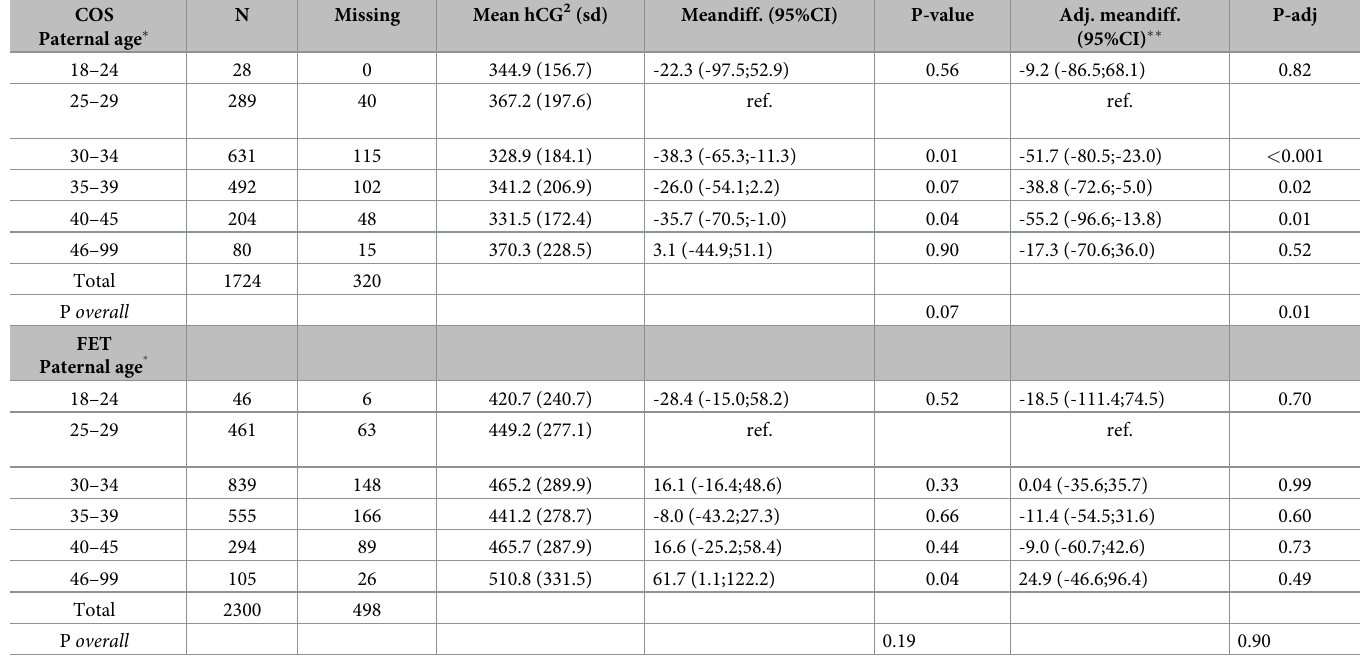
Linear regression. Multivariable linear regression. � Paternal age at oocyte pick up �� Adjusted for female age, female BMI, female smoking, diagnosis and clinic 1 human chorionic gonadotrophin 2 COS: Controlled Ovarian